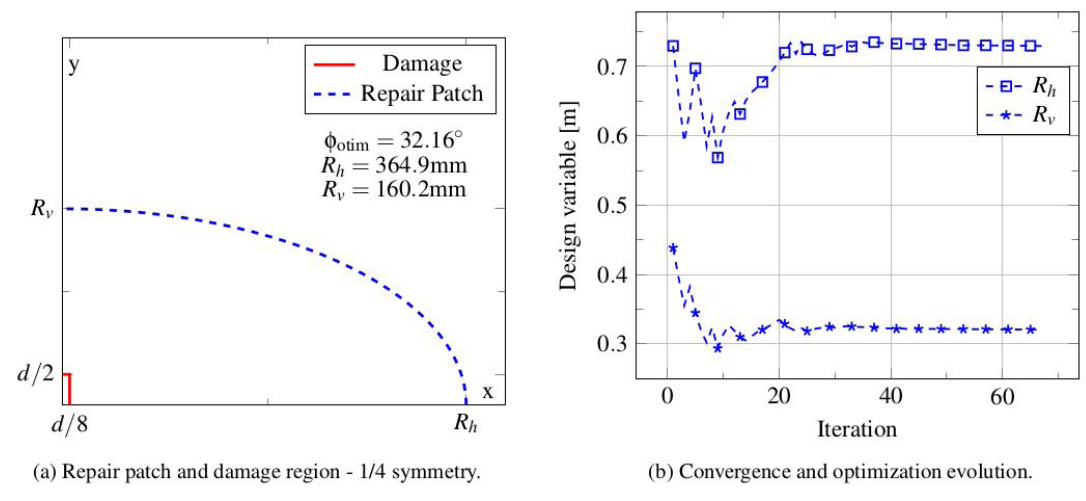
Figure 5. Elliptical repair patch - FC with an unsymmetrical stacking sequence.